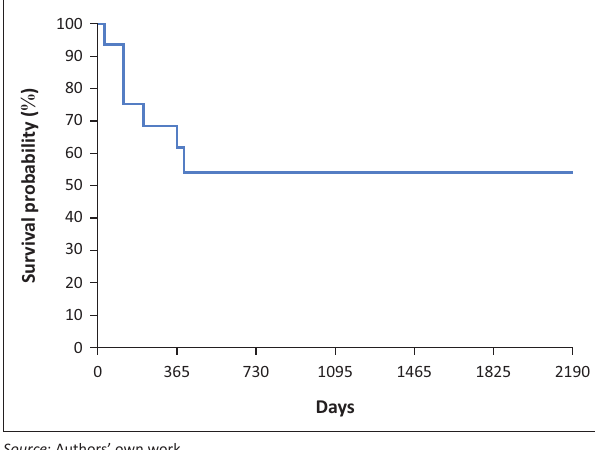
FIGURE 4: Kaplan Meier graph. Overall survival of the studied patients diagnosed with malignant neonatal